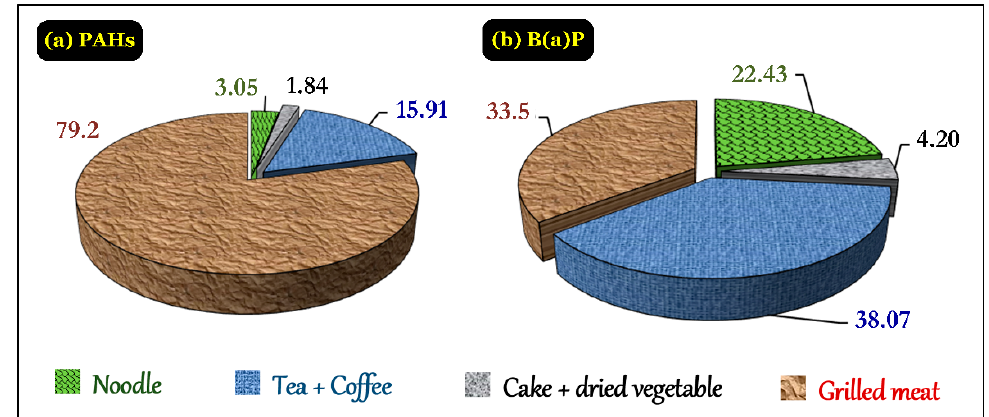
Figure 7. Distribution percentages of ( a ) PAHs and ( b ) benzo(a)pyrene (B(a)P) in the food samples.